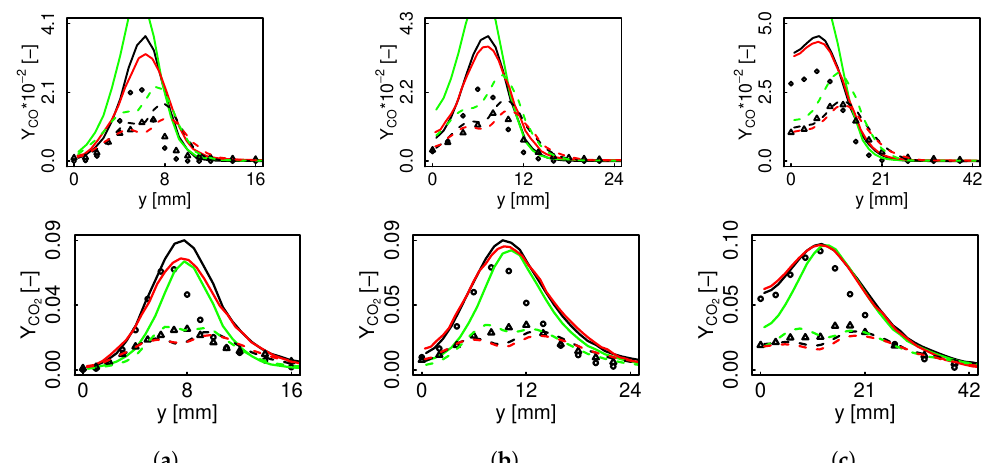
Figure 16. CO and CO 2 mean and RMS radial profiles for flame E. Black color represents non- premixed FTACLES, green color premixed FTACLES, red color FPV, solid line mean, dashed line RMS. Circles depict experimental mean, and triangles represent experimental RMS. ( a ) x / d = 7.5; ( b ) x / d = 15; ( c ) x / d = 30.